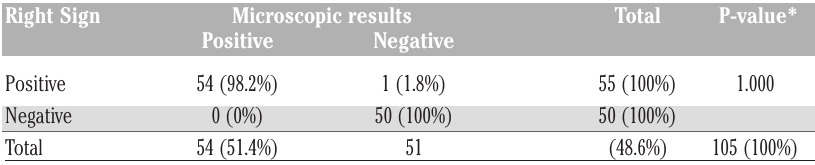
Table 3. Comparison of RightSign vs. microscopic examination.